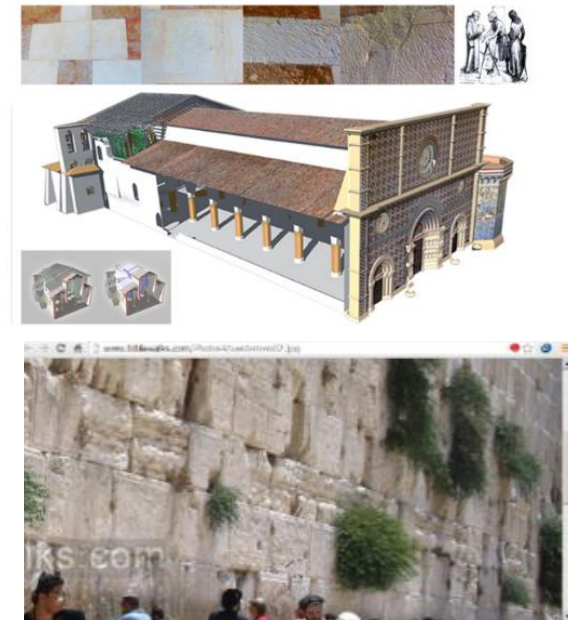
Figure 8. Repositories of materials, construction techniques